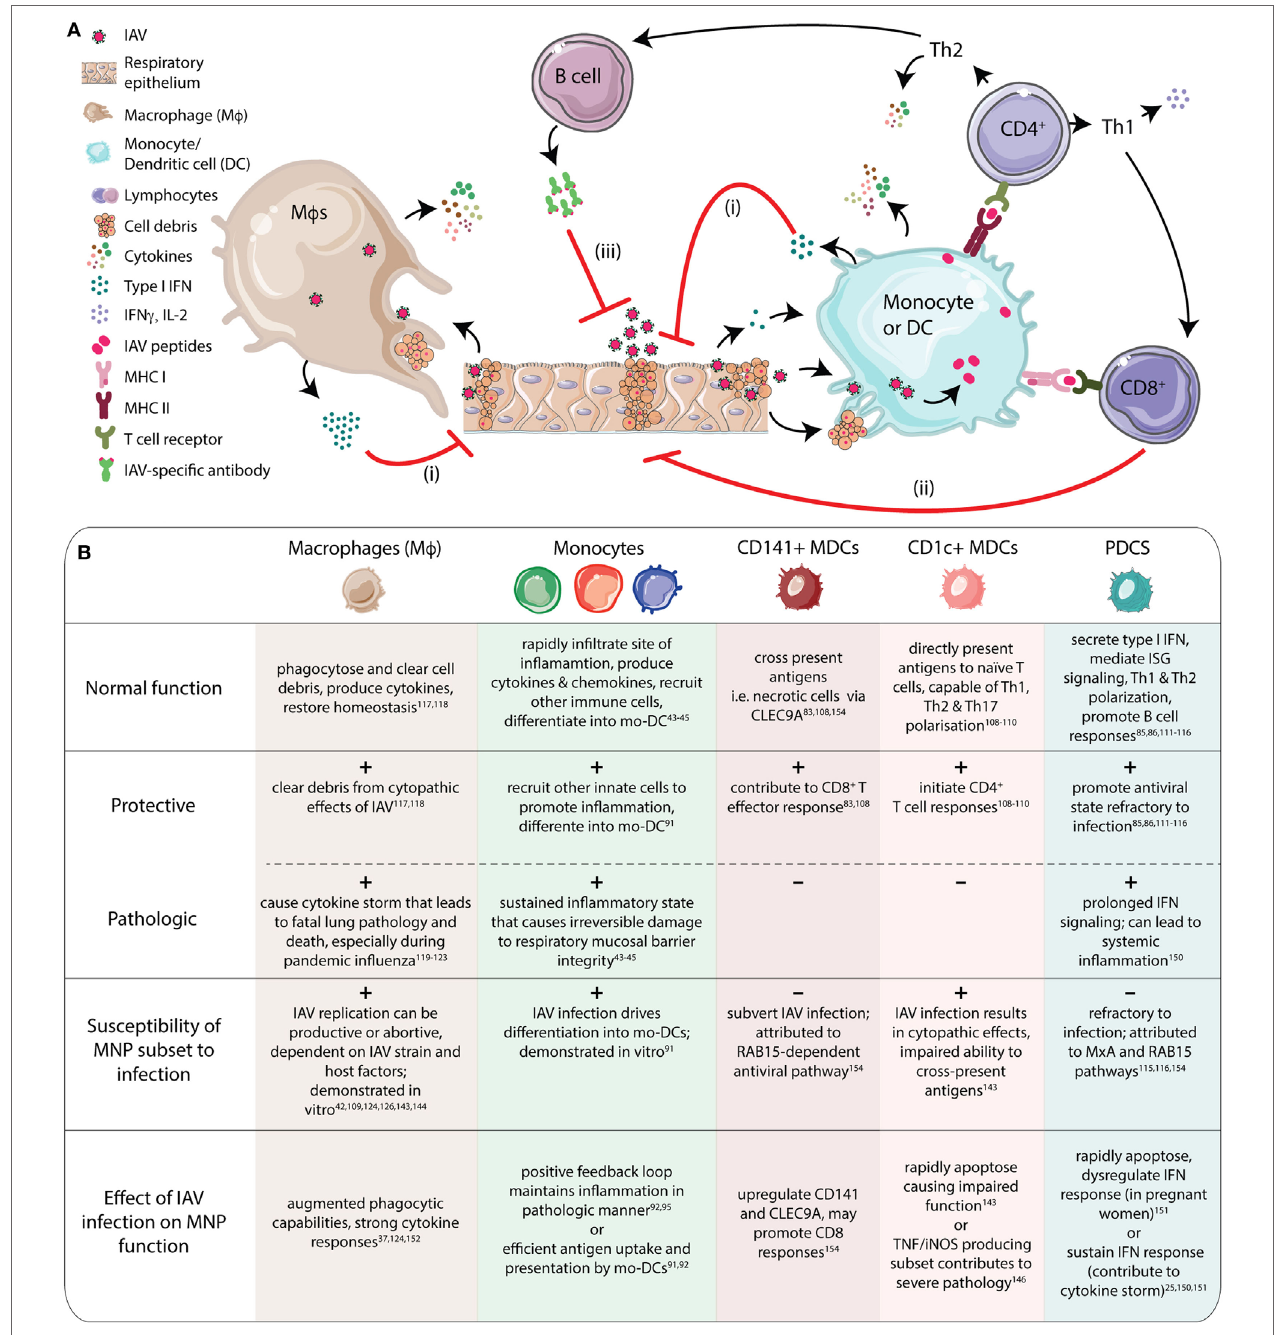
FigURe 2 | Human mononuclear phagocytes (MNPs) play a multitude of roles to mediate immune protection during influenza A virus (IAV) infection. (A) MNP subsets have many overlapping functions. Macrophages (M ϕ s) clear up cell debris and release cytokines. Monocytes and dendritic cells (DCs) can also release cytokines and present antigens to initiate adaptive responses. (i) Following IAV infection of respiratory epithelium, M ϕ s, monocytes, and DCs respond to the virus and cell debris, launching potent cytokine responses (TNF α , IL-6, IL-12p40, and IL-10), including interferon (IFN) α . Induction of interferon-stimulated genes (ISGs) promotes an antiviral state in bystander cells, protecting them from infection. (ii) The antigens taken up by monocytes/DCs are processed and presented via MHC I and II to CD8 + and CD4 + T cells, respectively. Antigen-specific CD8 + T cells perform effector functions via cytotoxic granule- and FasL-mediated caspase- dependent apoptosis. (iii) CD4 + T cells mature into subsets with specific functions. Th1 cells primarily produce IFN γ , IL-2, and TNF β ; and aid CD8 + T cell proliferation. Th2 cells on the other hand, produce IL-4, IL-5, and IL-13 and assist B cells, especially during antibody class switching, promoting production of neutralizing antibodies. Induction of broadly neutralizing antibodies against all strains of influenza virus remains a challenge in the field of influenza immunology (45, 57, 75, 76, 96–106). (B) The table summarizes the individual functions of MNP subsets that can protect against IAV infection, but also contribute to pathology. Most MNP subsets are susceptible to IAV infection, as demonstrated by in vitro studies. As a consequence of IAV infection, MNP function can be directly affected, prompting them to respond in a protective or pathologic fashion (25, 37, 42–45, 73, 75, 76, 91, 102–105,